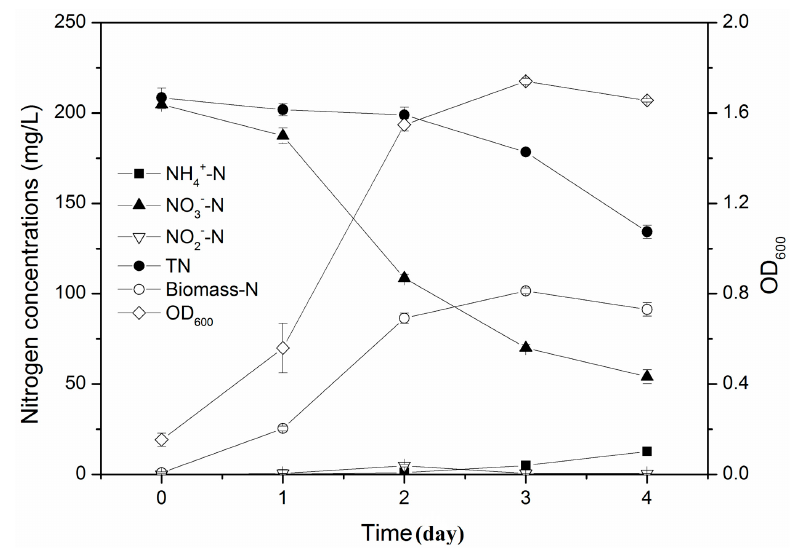
Figure 2. Aerobic denitrification characteristics of strain Y-12 in the presence of NO 3 − -N.